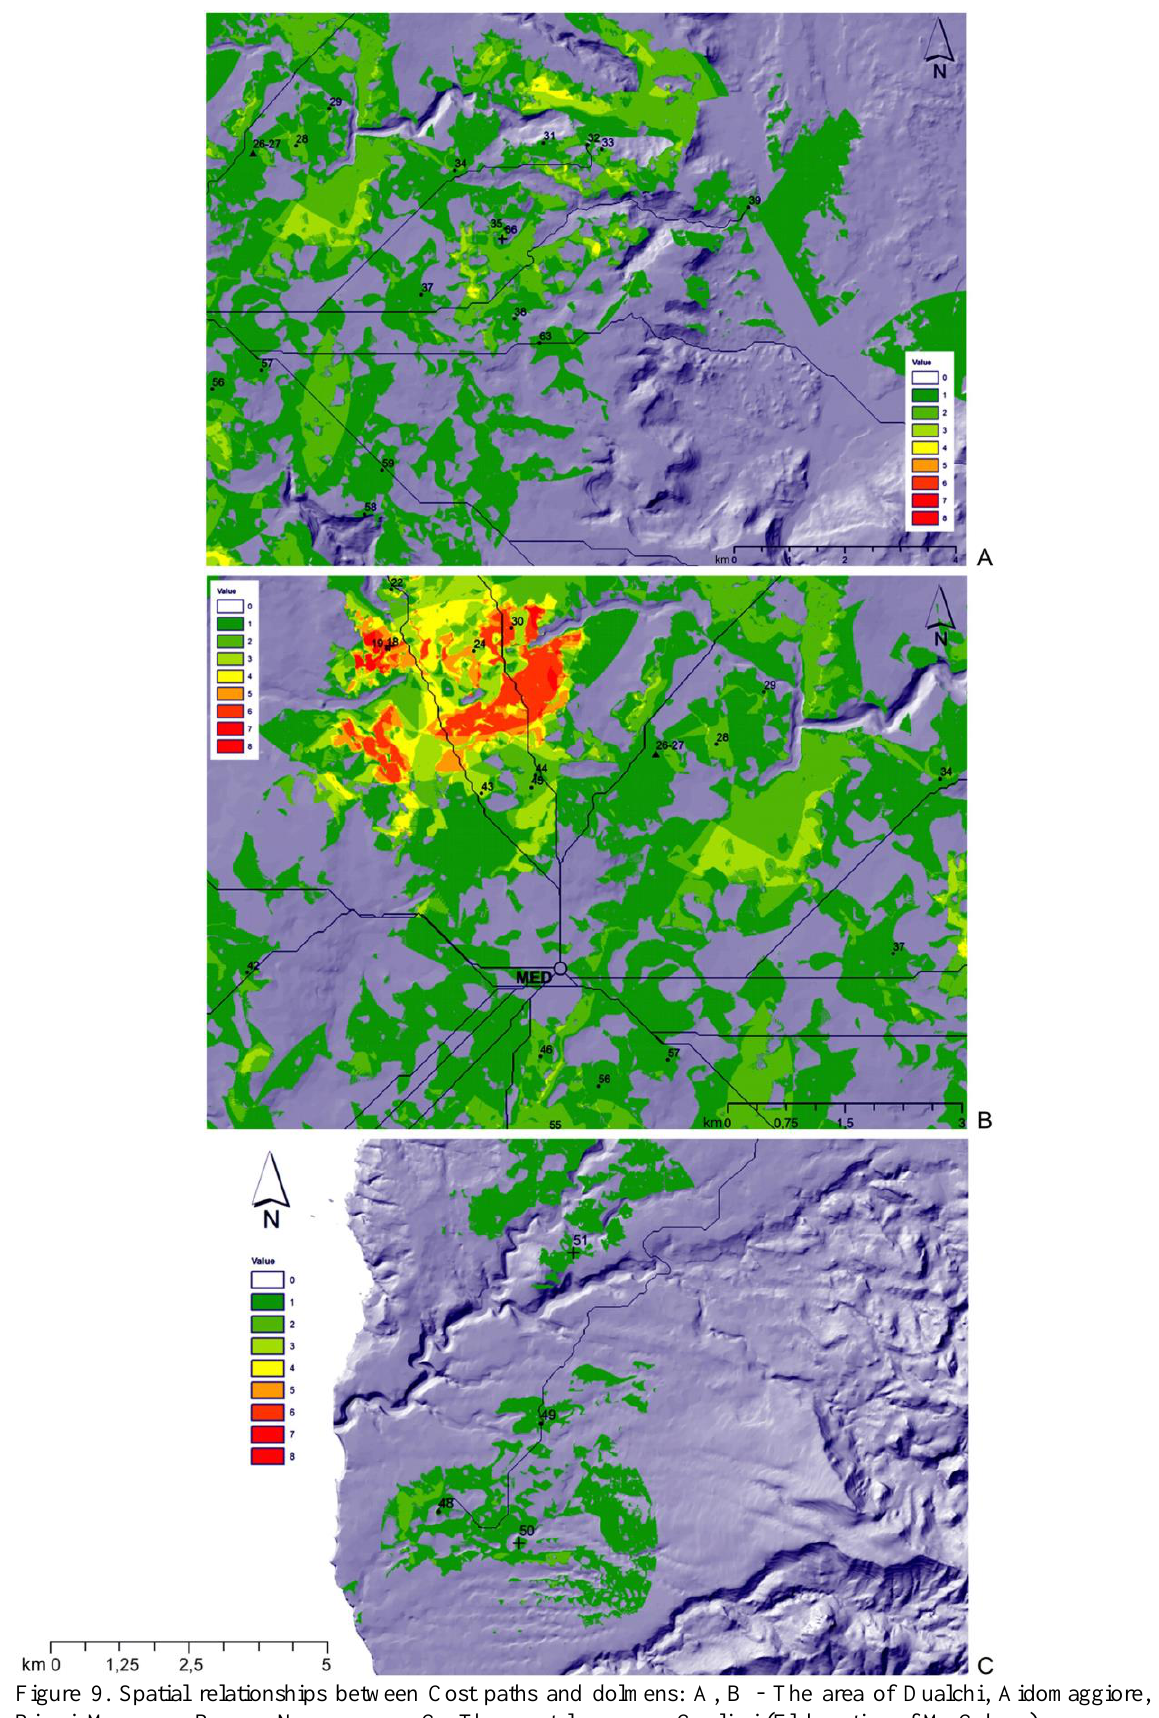
Figure 9. Spatial relationships between Cost paths and dolmens: A, B - The area of Dualchi, Aidomaggiore, Birori, Macomer, Borore, Noragugume; C - The coastal area near Cuglieri (Elaboration of M.